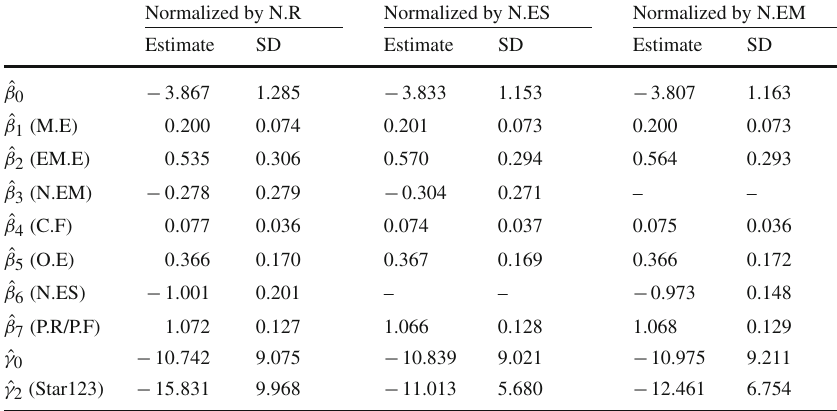
Table 5 Estimation results of the best models under different normalizations Normalized by N.R Normalized by N.ES Normalized by N.EM Estimate SD Estimate SD Estimate